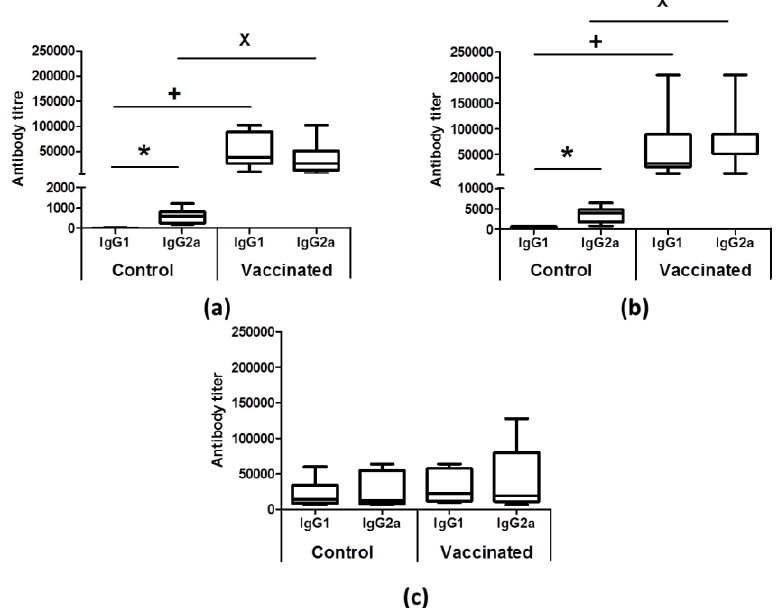
Figure 3. Vaccinated animals develop an earlier parasite-specific antibody response than controls after infective challenge. The reciprocal end-point titer of IgG1 or IgG2a against leishmanial antigens was determined by ELISA from sera samples taken at the silent phase ( a ; 1 week post-challenge), at the initial phase ( b ; 5 weeks post-challenge), and at the late phase of infection ( c ; 11 weeks post-challenge). Sera samples from control (n = 8) and vaccinated ( n = 8) animals were studied individually. Data are represented as box and whisker (min to max) plots and statistics were analyzed by a Mann–Whitney test. * ( p < 0.05) shows the statistical di ff erences between IgG1 and IgG2a titers in the control group. + ( p < 0.05) or × ( p < 0.05) shows the statistical di ff erences between vaccinated and control groups of IgG1 or IgG2a titers, respectively. Results are representative of two independent experiments.